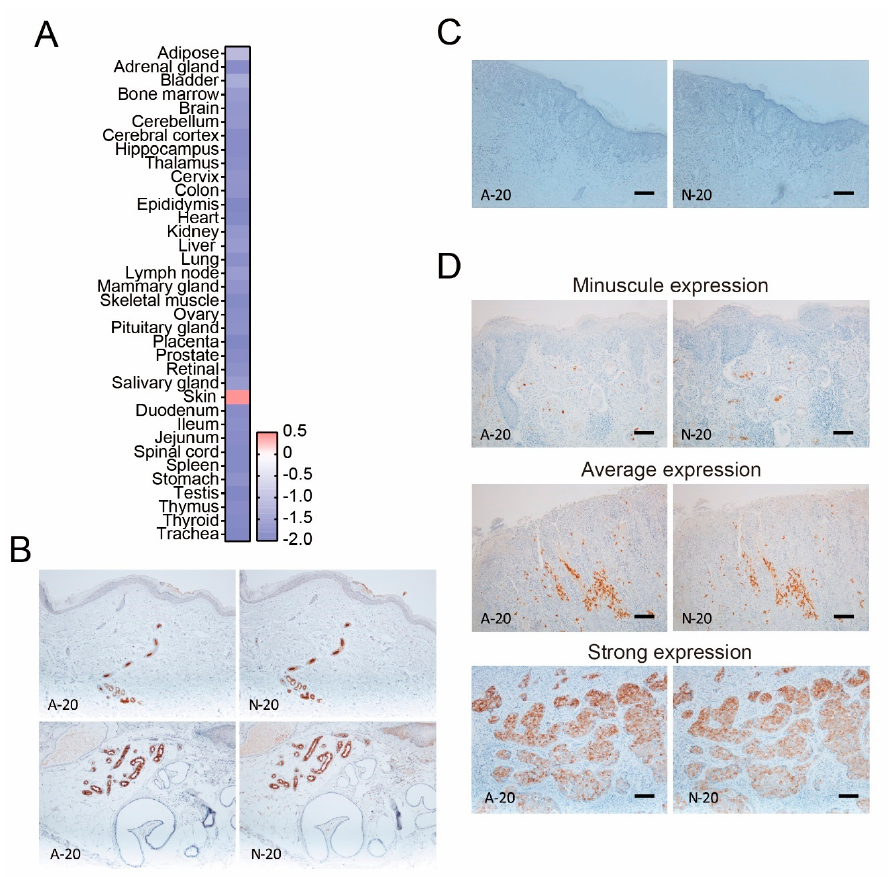
Figure 1. Dermcidin expression in healthy tissue and in the skin and positive staining in extramammary Paget’s disease. ( A ) Microarray dataset analysis of dermcidin gene expression; ( B ) representative dermcidin immunostaining for eccrine glands in healthy subjects using two different immunostaining antibodies; ( C , D ) representative negative and ( C , D ) positive staining patterns of dermcidin were observed in extramammary Paget’s disease tumor in both intraepithelial and dermal invasive tumors. ( C ) Scale bar: 100 μ m; ( D ) scale bar: minuscule expression and average expression were determined at 100 μ m, and strong expression was determined at 50 μ m.